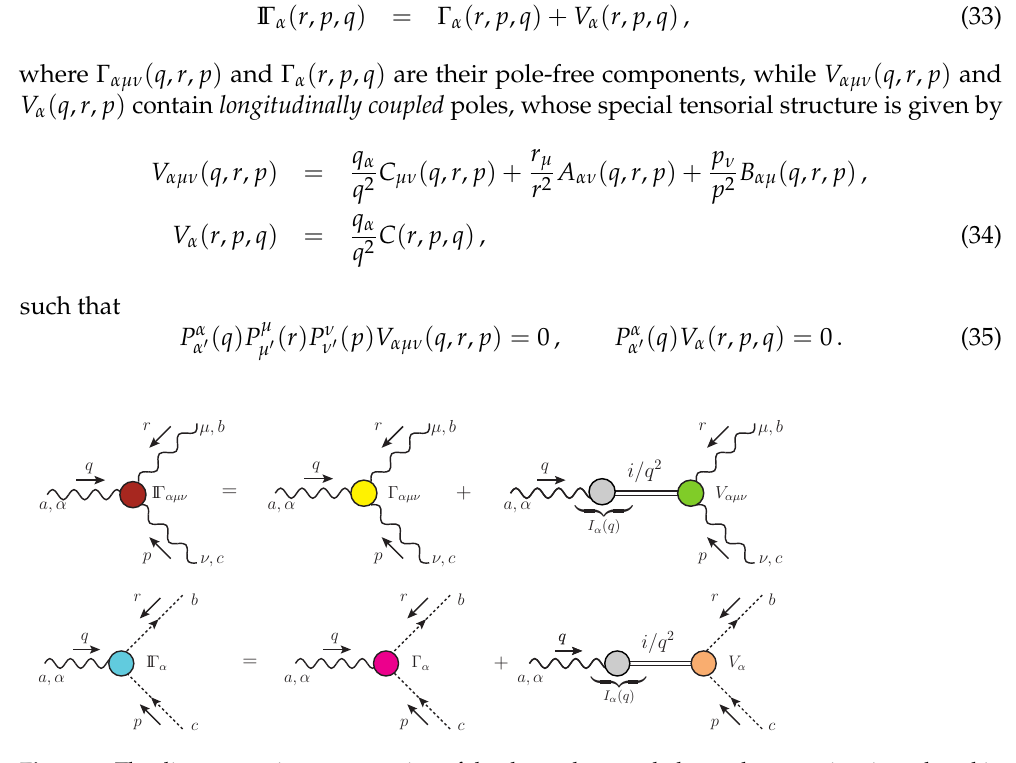
Figure 3. The diagrammatic representation of the three-gluon and ghost–gluon vertices introduced in Equation (33): I Γ αµν ( q , r , p ) (first row) and I Γ α ( r , p , q ) (second row). The first term on the r.h.s. indicates the pole-free part, Γ αµν ( q , r , p ) or Γ α ( r , p , q ) , while the second denotes the pole term V αµν ( q , r , p ) or V α ( r , p , q )